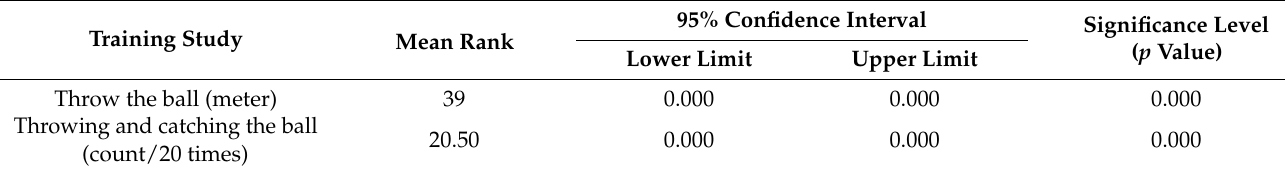
Table 5. Wilcoxon signed-ranks test for pre- and post-training study of throwing the ball and of throwing and catching the